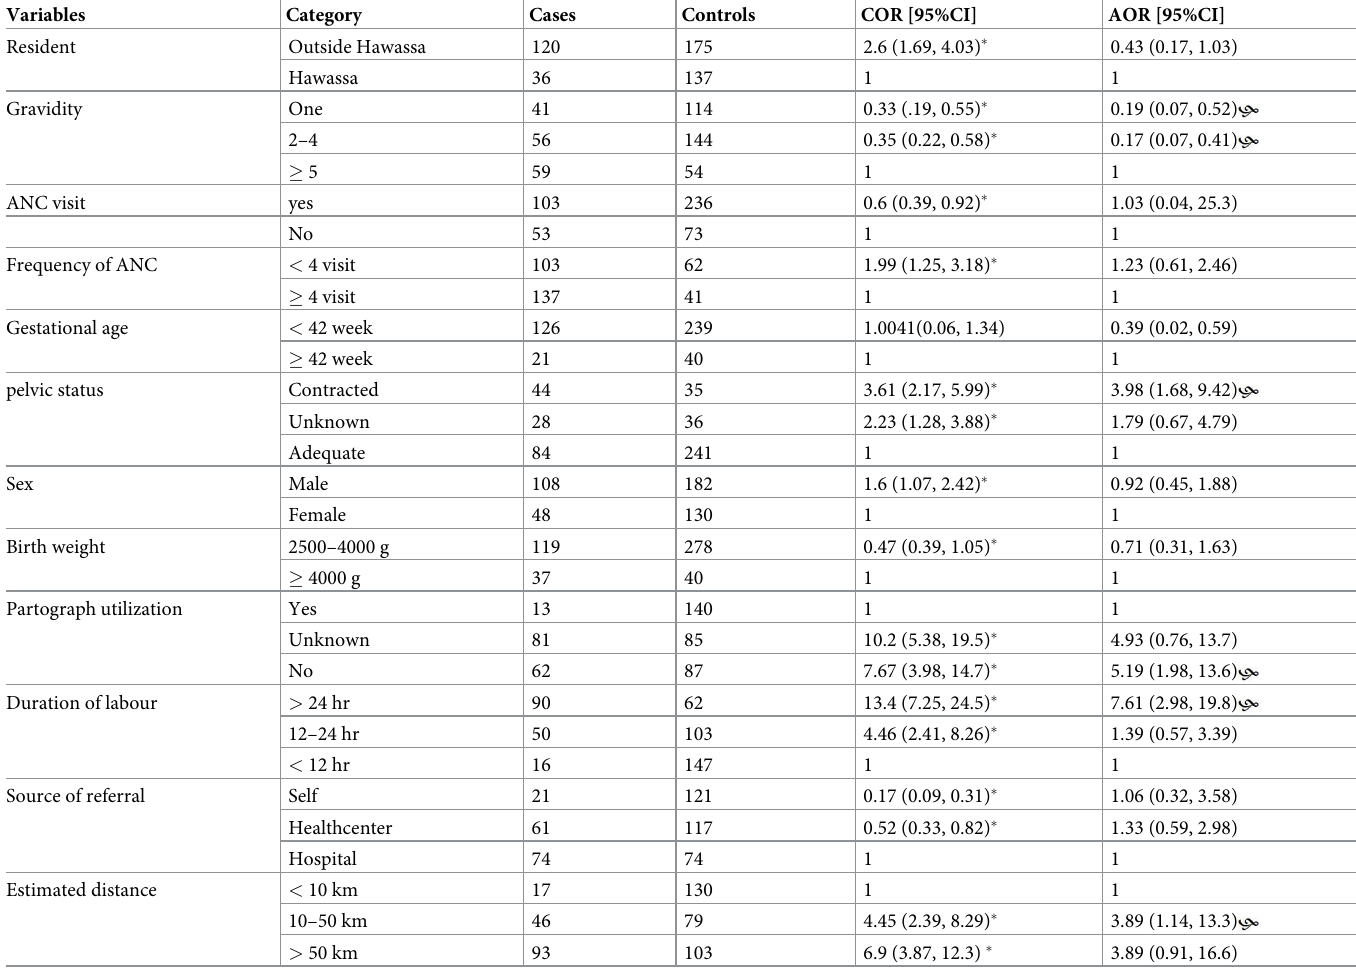
Table 3. Determinants of obstructed labour in Hawassa referral Hospital, among women who gave birth in HUCSH from 2015–2017. Determinants of obstructed labour in HUCSH, southern Ethiopia, 2018.